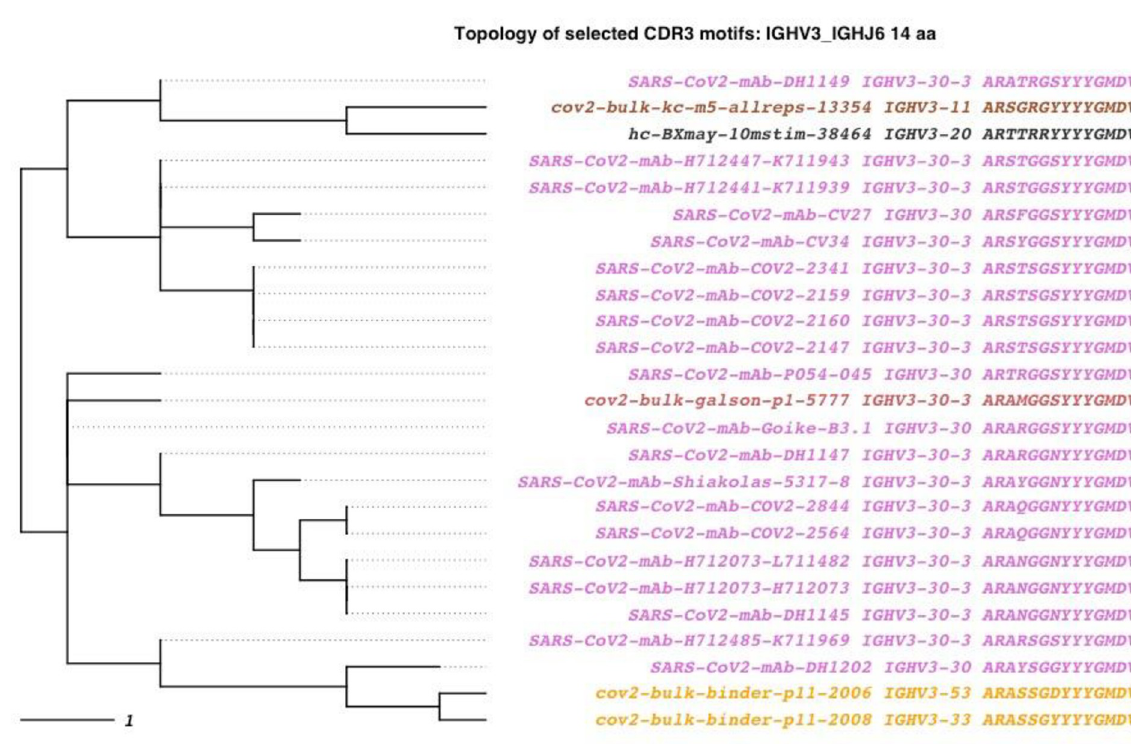
Fig 5. SARS-CoV-2 convergent clonotypes to mAb DH1149 in the 3_6_14 bin. An 80% identity threshold is used to calculate convergence. Tips are colored by dataset source. Purple tips are published anti-COVID-19 antibodies from 7 different studies, dark gray tips are antibody sequences from a healthy donor BCR repertoire, and orange through brown shaded tips are antibody sequences from COVID-19 patient BCR repertoires.